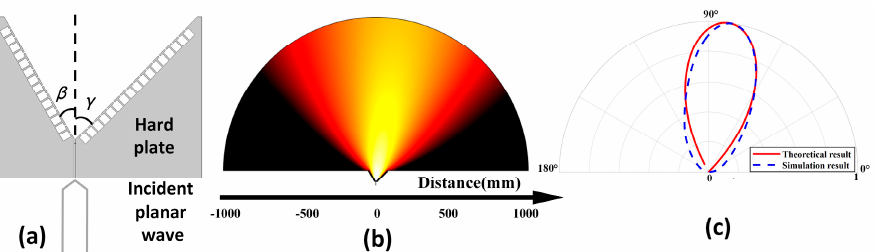
≈ cZ ρ . ( c ) Theoreti- 00 s